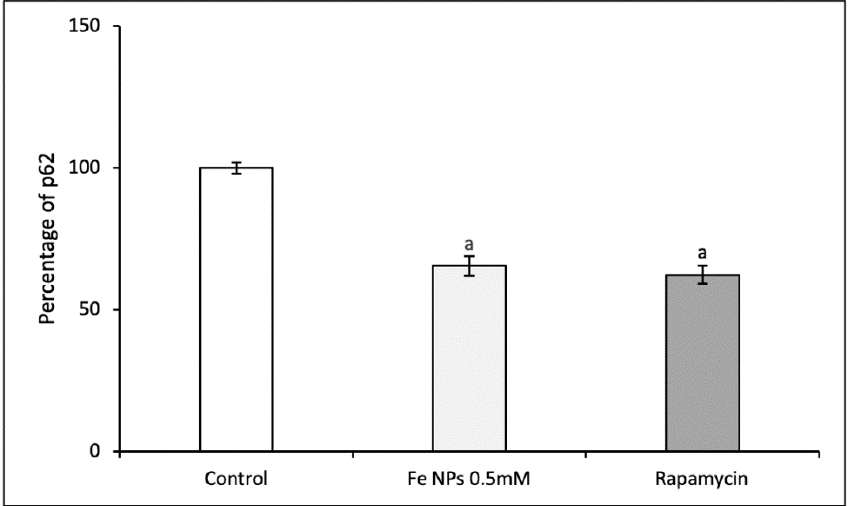
Figure 9. Percentage of p62 (respect control cells) in HT-29 cells exposed to Fe NPs 0.5 mmol L − 1 , rapamycin 0.5 µ mol L − 1 . Results expressed as mean ± SEM. (a) vs. control ( p <